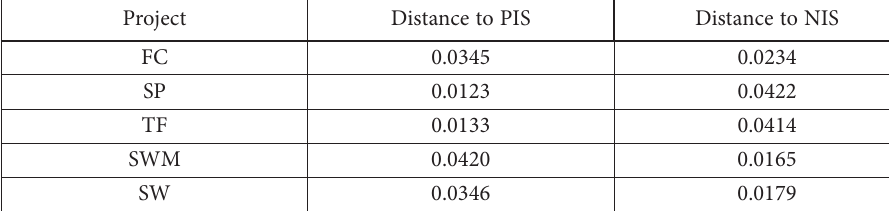
Table 9. The distance of five projects to PIS and NIS Project